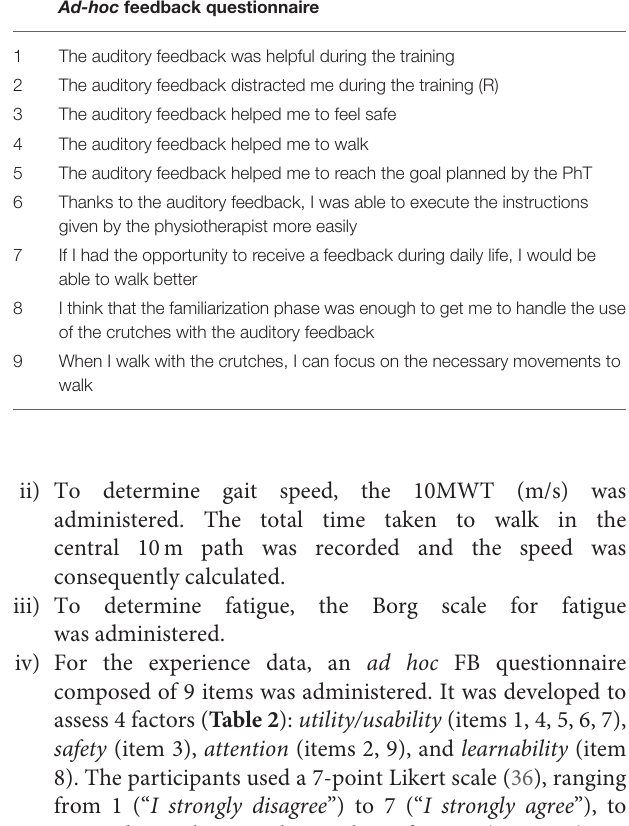
TABLE 2 | List of items included in the ad-hoc feedback questionnaire. Ad-hoc feedback